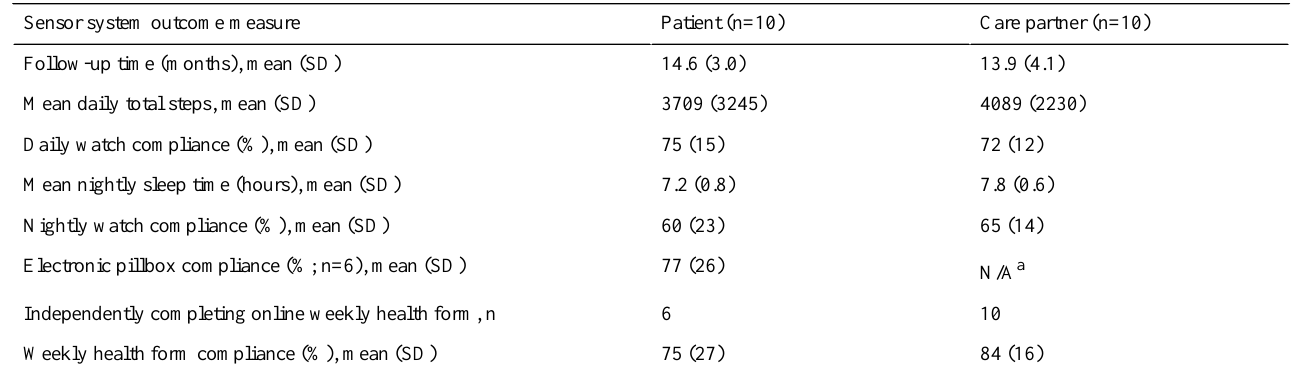
Table 4. Summary of sensor-based measures in patient participants and care partners.